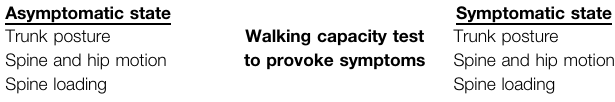
Frontiers in Bioengineering and Biotechnology |